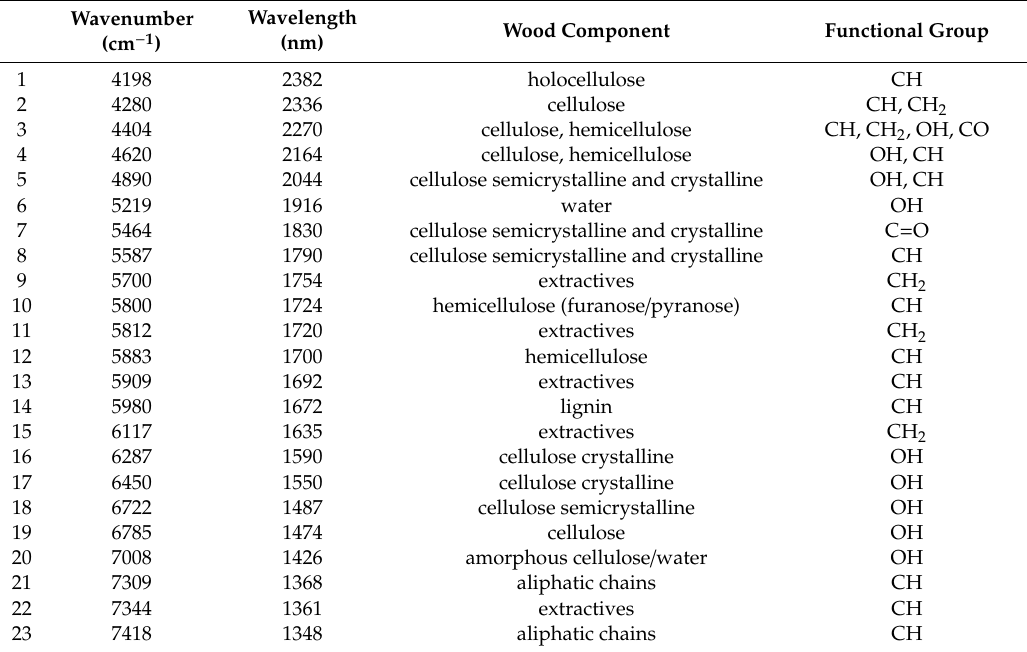
Table 2. Band assignment characteristic for wood, according to Schwanninger et al. [31] and Vagnini et al.